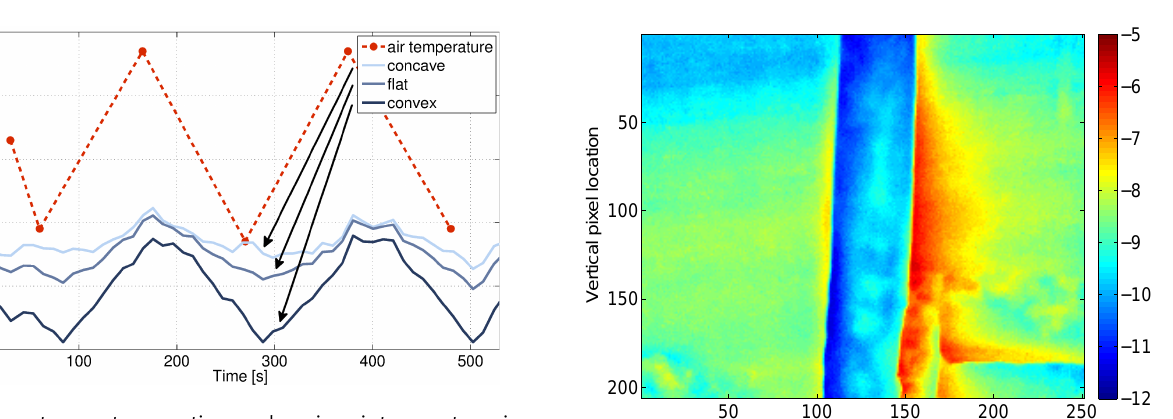
Horizontal pixel location